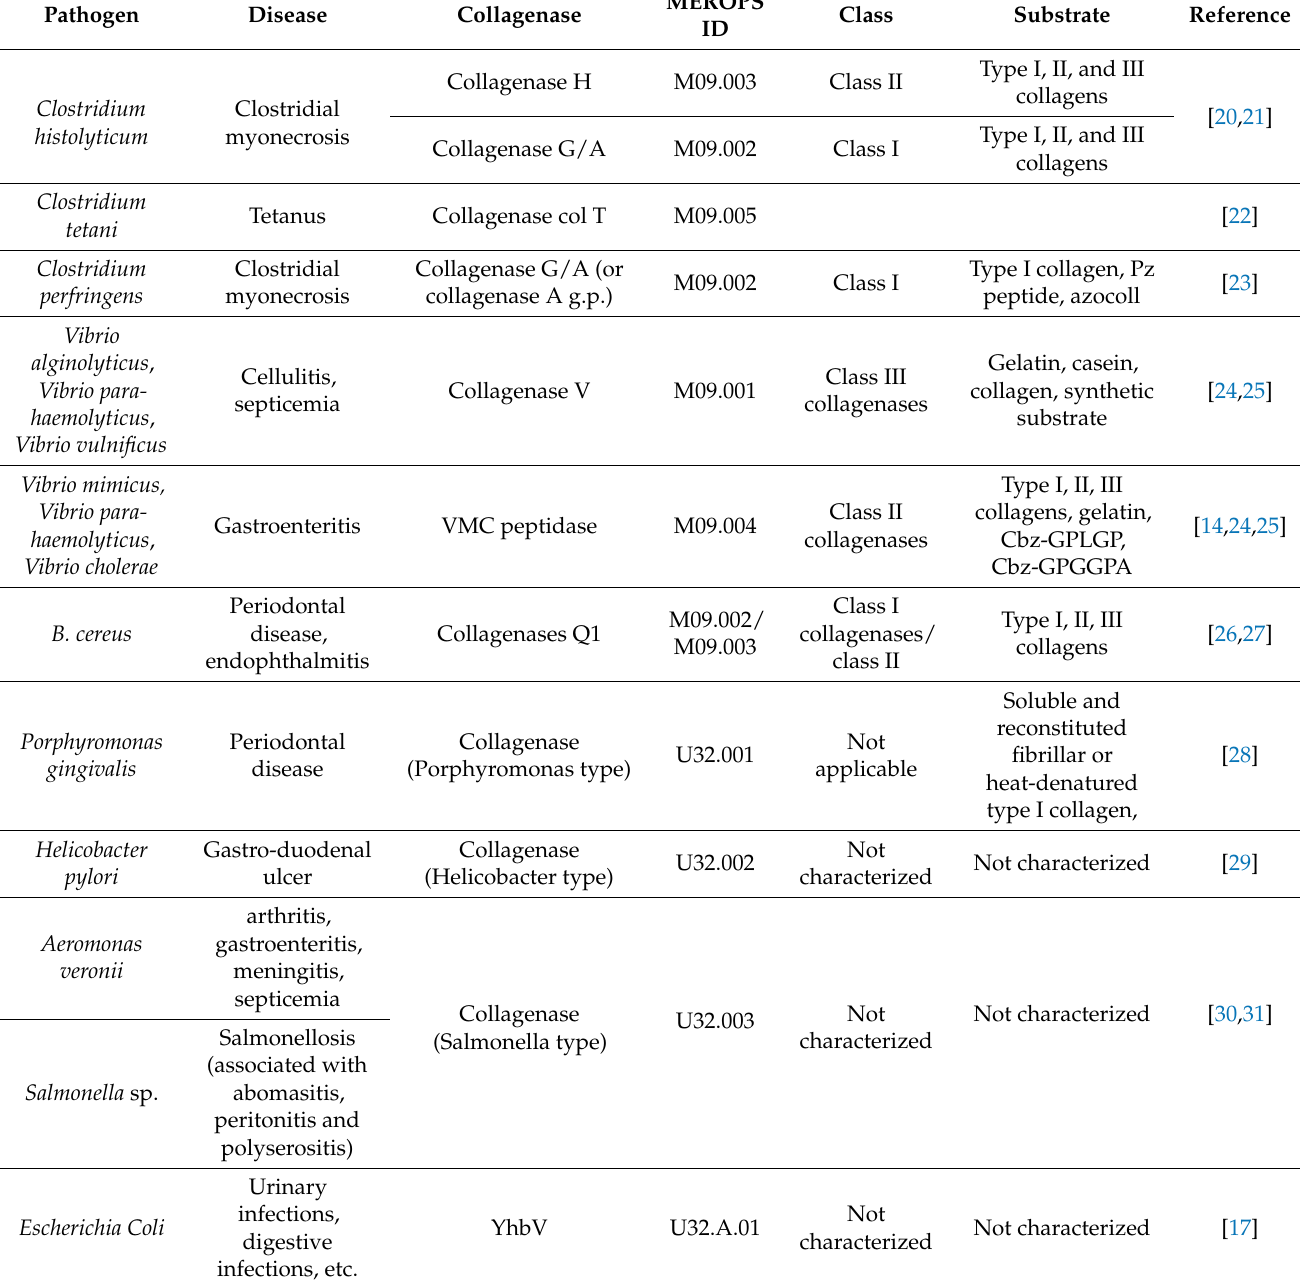
Table 1. Collagenases associate with pathogenic